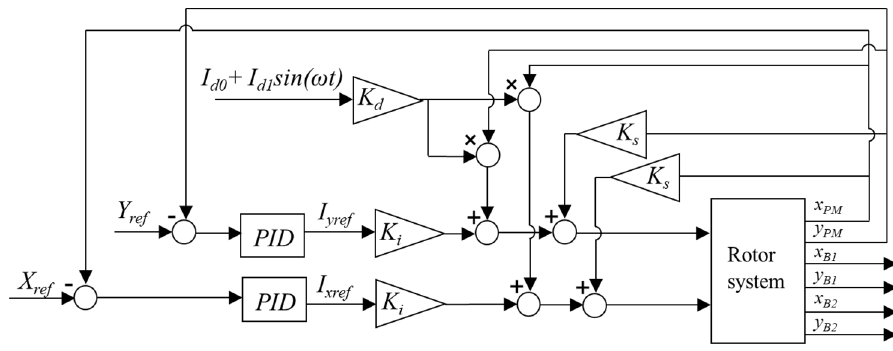
Figure 3. Block diagram of the rotor system. Table 2. Specifications of the rotor system.